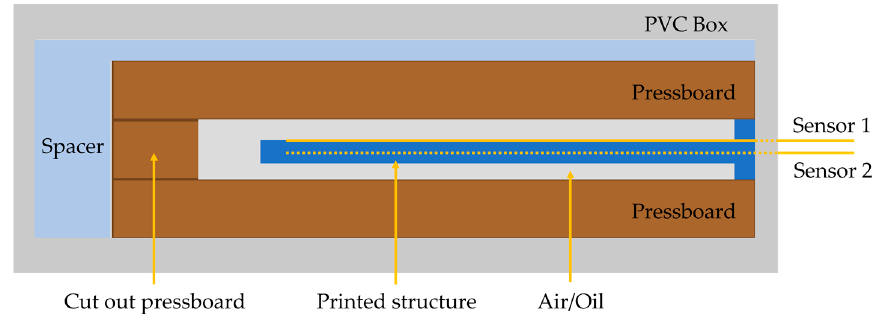
Figure 5. Schematic diagram of the simulated environment.